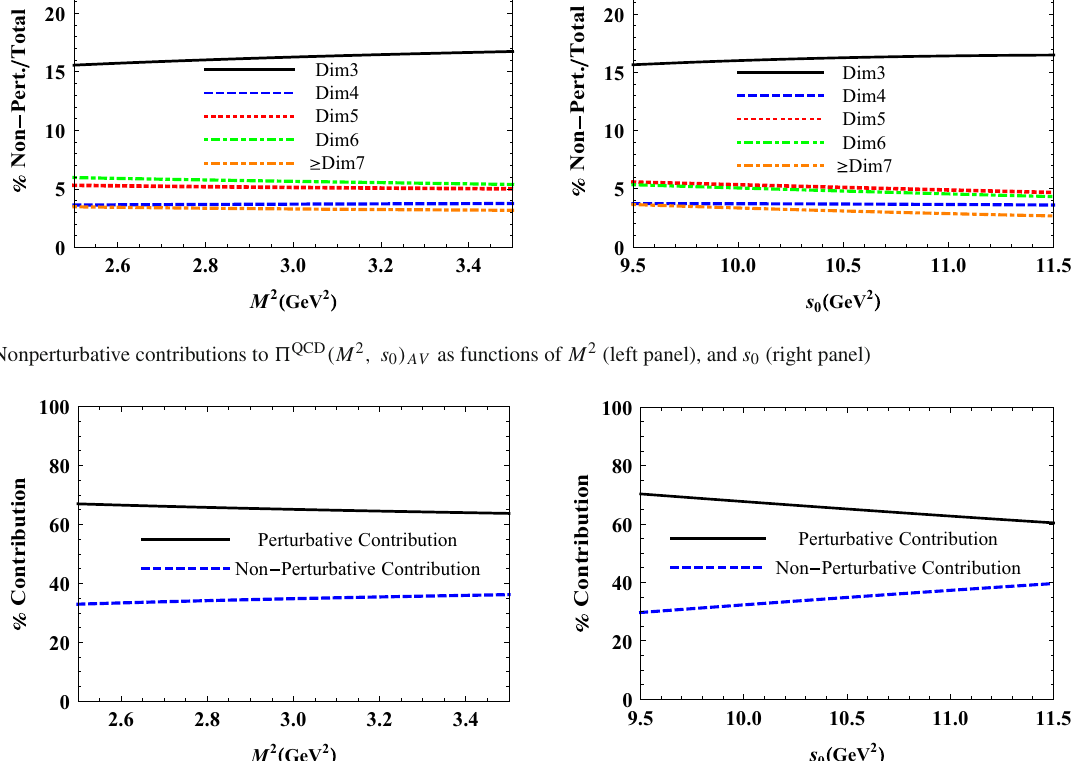
decay channels of the scalar tetraquark. It is evident that in all these channels the final mesons are particles with negative charges. For simplicity of expressions throughout this